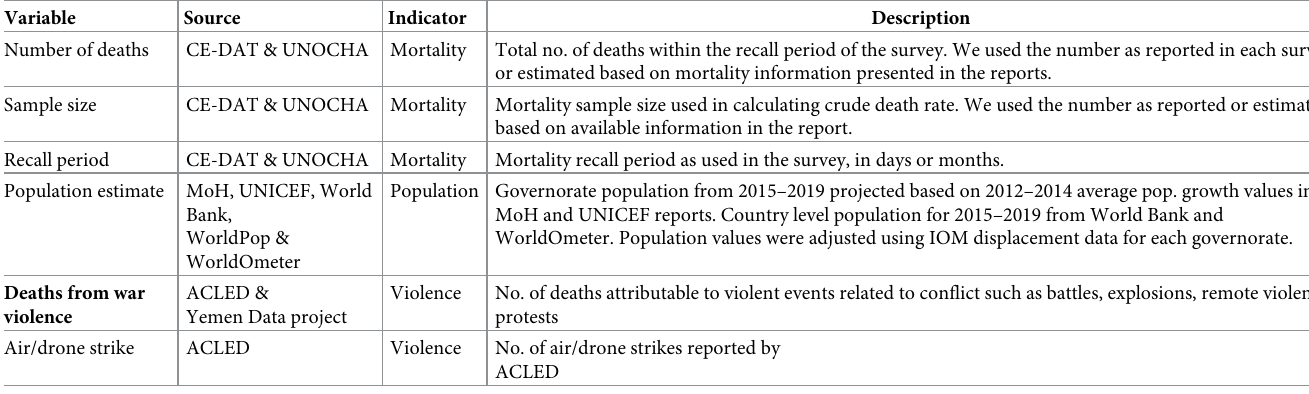
Table 1. Summary characteristics of data sources for the period 2012–2019,